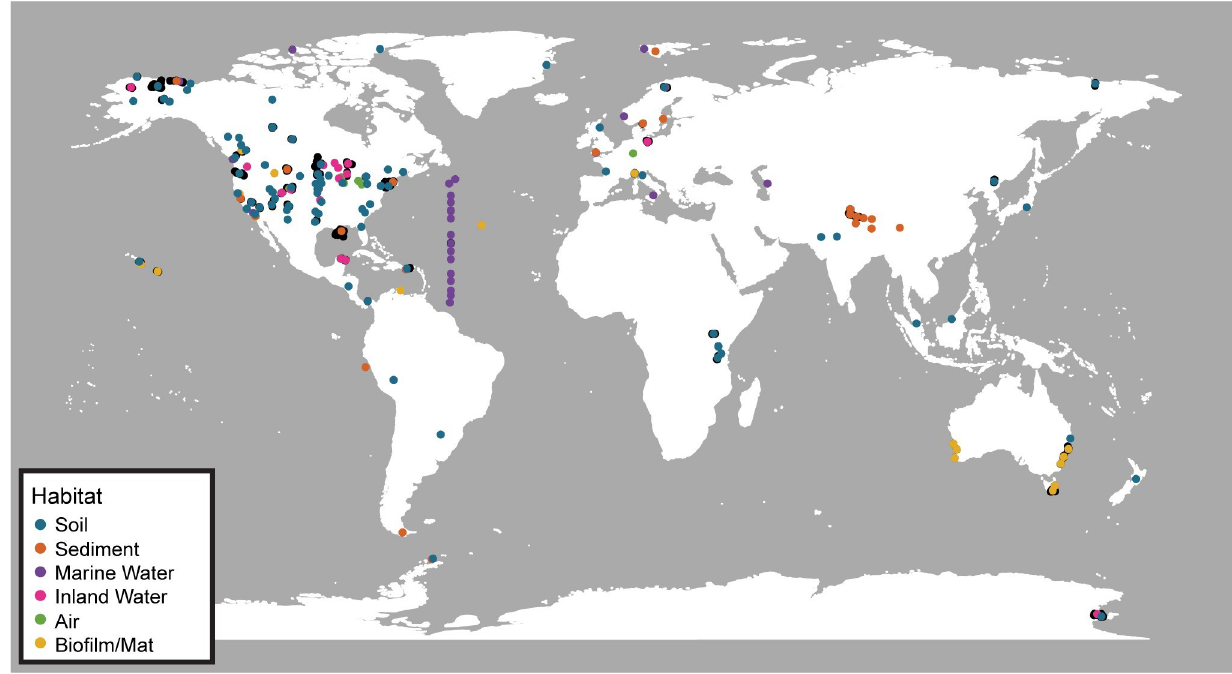
Fig 1. Sample and geocluster locations. Map showing locations of each of the EMP samples used in this study (black dots) and the geoclustered samples for each habitat (colored dots). Geoclusters were created from samples located within 110 km of each other.